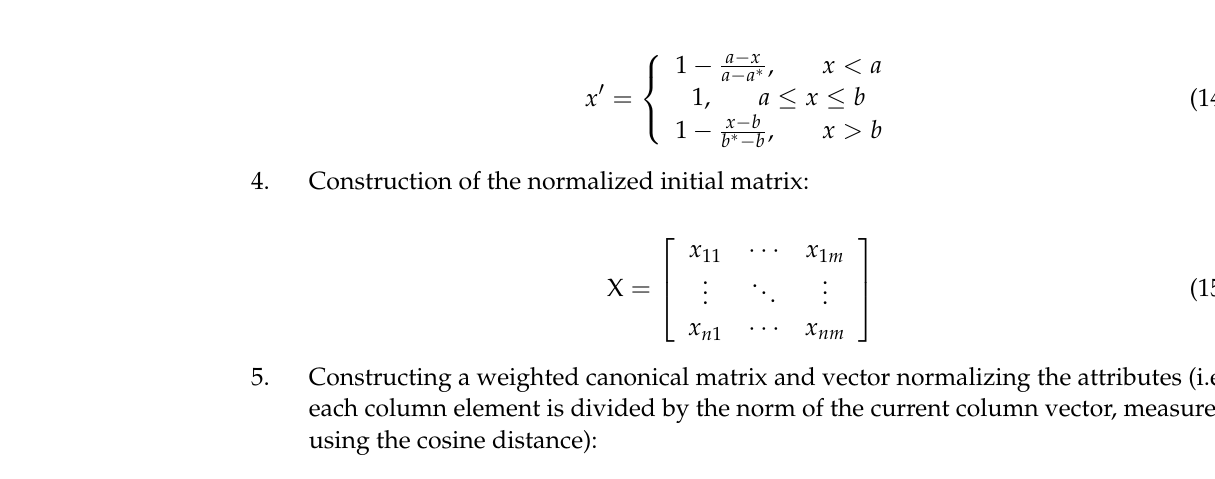
5. Constructing a weighted canonical matrix and vector normalizing the attributes (i.e., each column element is divided by the norm of the current column vector, measured using the cosine distance):